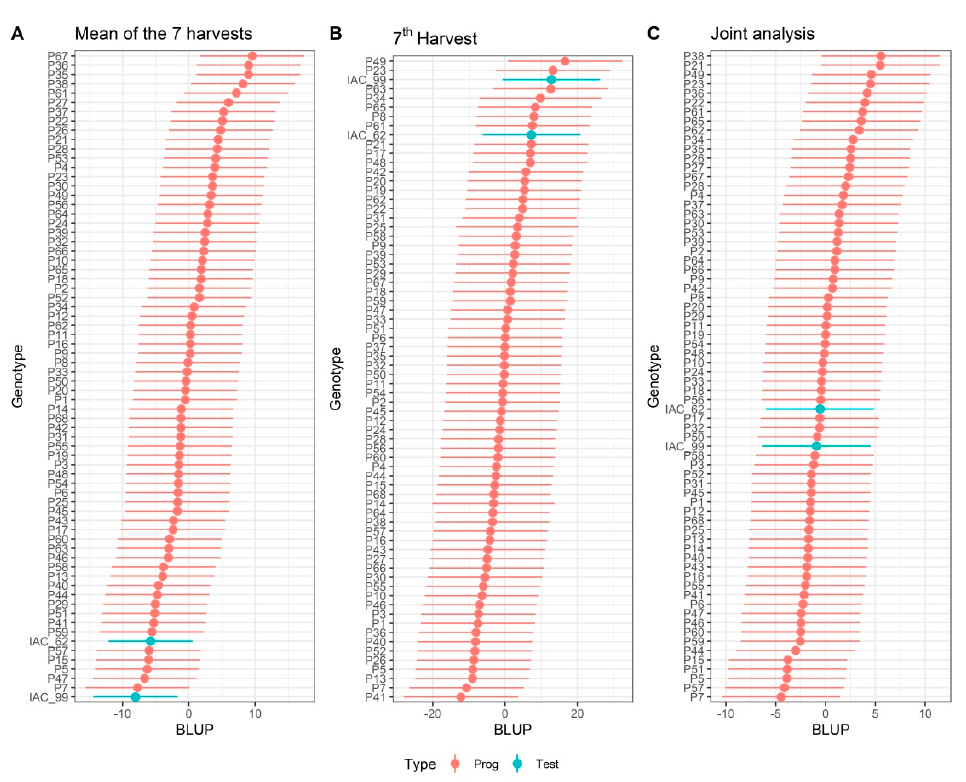
Figure 1. Prediction interval for the genetic values (BLUPs) of the F 4:5 coffee progeny productivity using the following models: ( A ) mean of the seven harvests, ( B ) only the seventh harvest, and ( C ) the harvest × progeny interaction when considering all seven harvests.